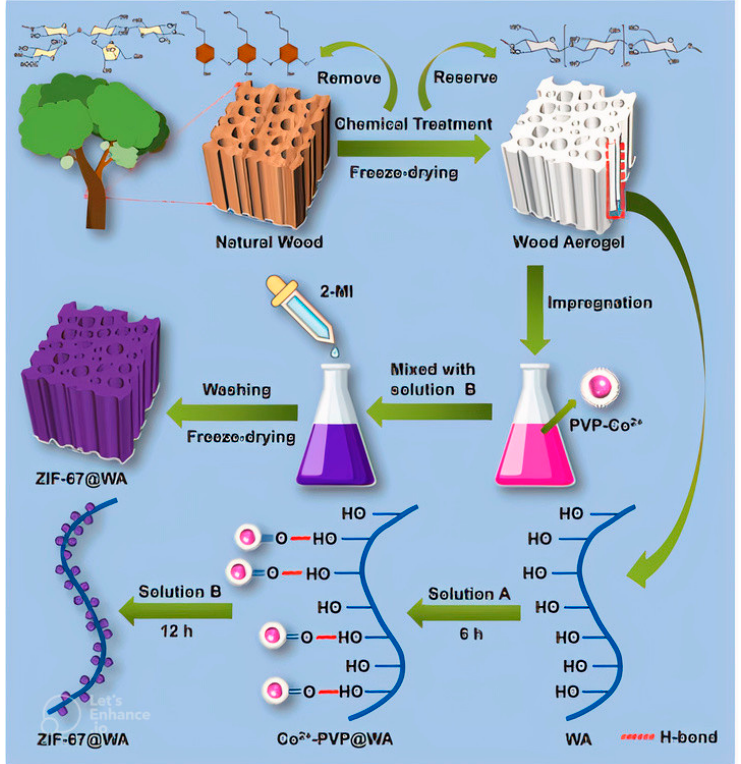
Figure 7. Process of ZIF-67@WA fabrication, reproduced with permission from [174]. Copyright Elsevier, 2021.